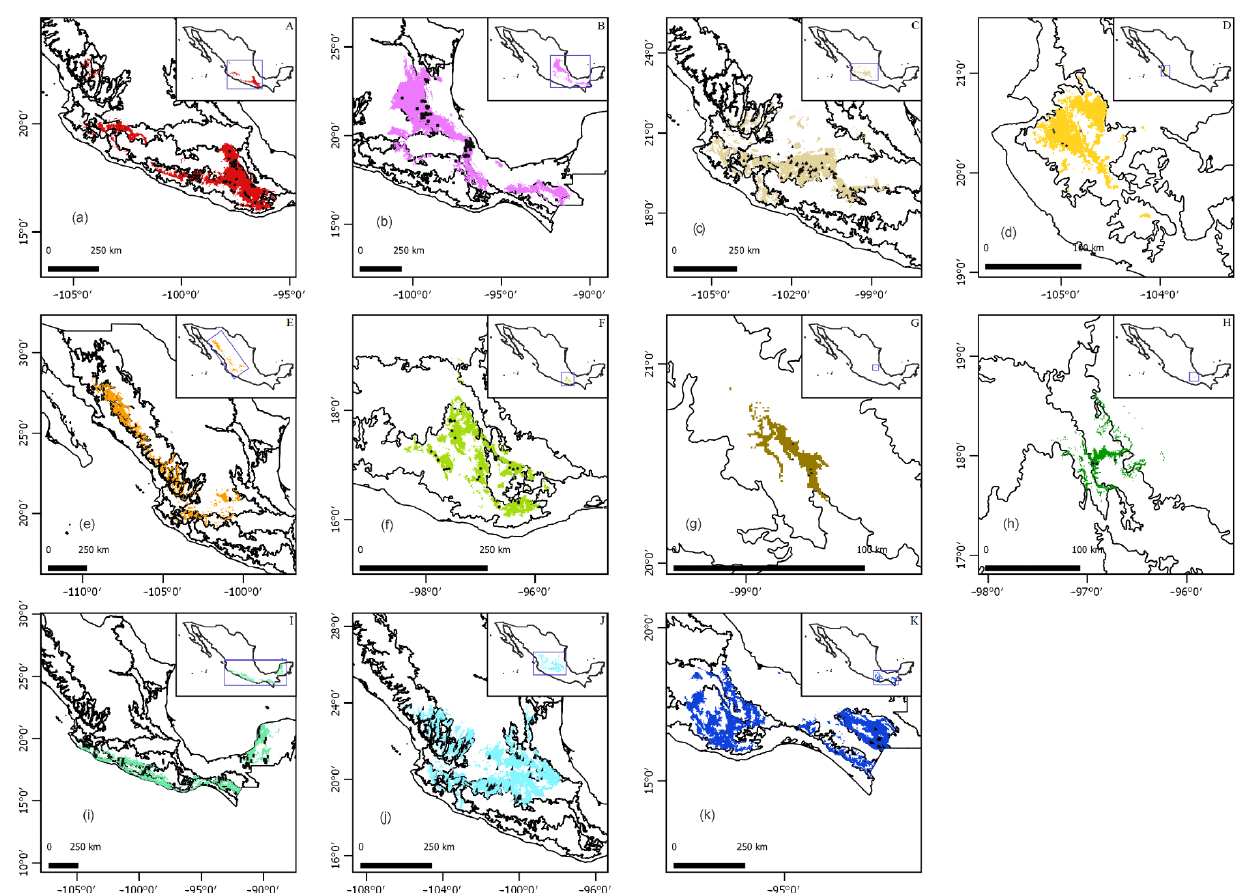
Figure 6. Potential distribution areas of ( a ) Laelia albida , ( b ) * Laelia anceps , ( c ) Laelia autumnalis , ( d ) Laelia crawshayana , ( e ) Laelia eyermaniana , ( f ) Laelia furfuracea , ( g ) × Laelia gouldiana , ( h ) * Laelia halbingeriana , ( i ) * Laelia rubescens , ( j ) Laelia speciosa , and ( k ) * Laelia superbiens . *Taxa proposed to be transferred to Schomburgkia and × taxon proposed in a new combination × Schombolaelia gouldeana by Peraza-Flores et al. [12]. Table 4. The analysis of variance by principal component.